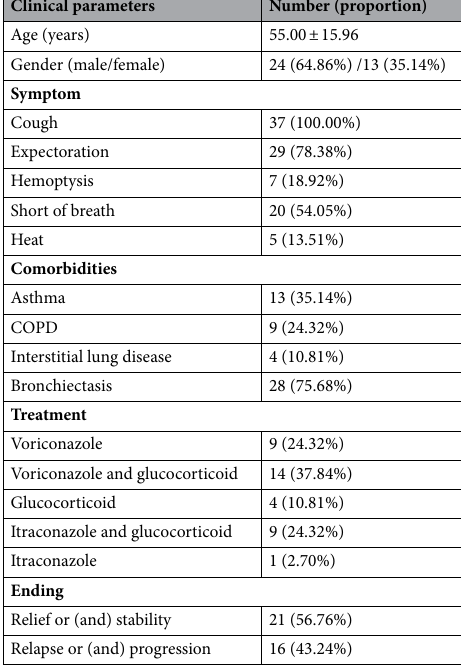
Table 3. Demographics and clinical features of 37 patients with ABPA (n = 37).